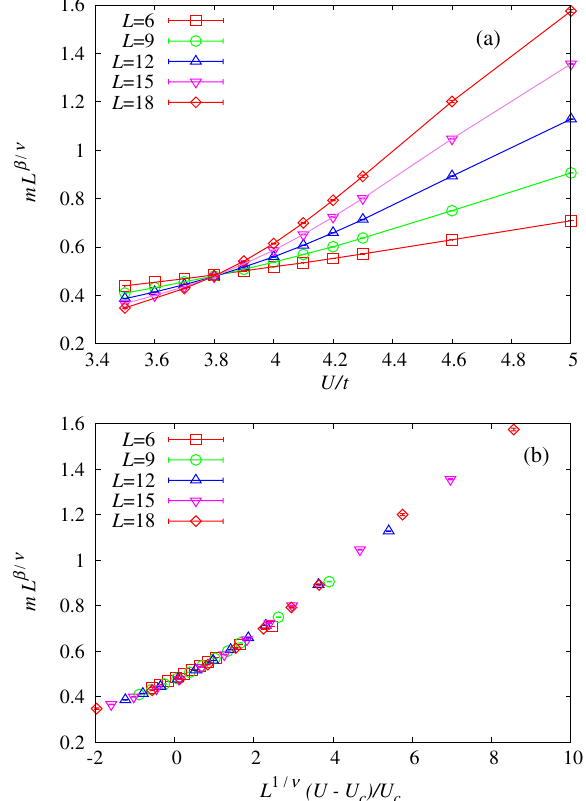
FIG. 6. Data collapse for the single-particle gap. The expo- nents are taken for the (cid:8) expansion of Ref. [6]. (a) The crossing point pins down the value of U c . (b) The data collapse again using U c =t ¼ 3 : 78 . For comparison, we have included the data for the magnetization.